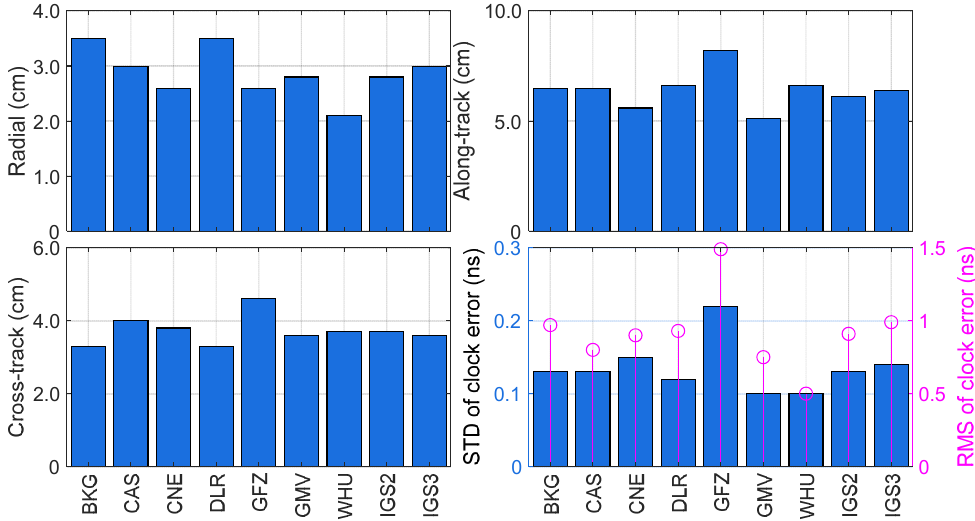
Figure 5. The accuracy of Galileo SSR products. The STD (Left y axis and blue) and RMS (Right y axis and magenta) of clock errors is presented in the lower-right subplot.